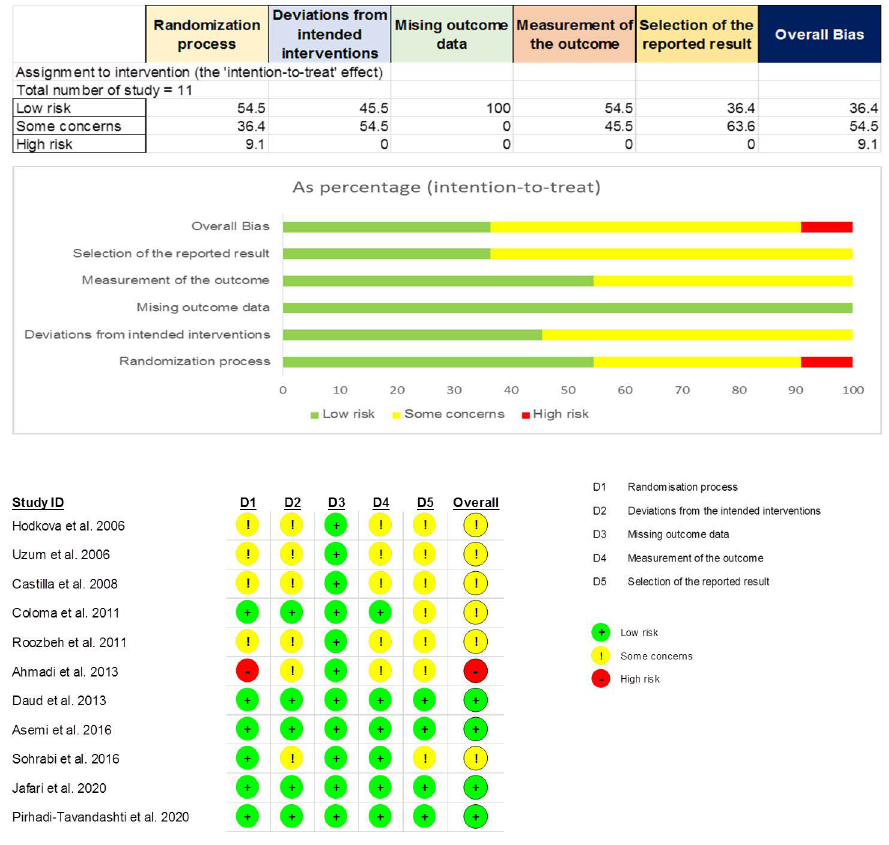
Figure 2. Risk of bias assessment by Cochrane risk-of-bias tool version 2 for included